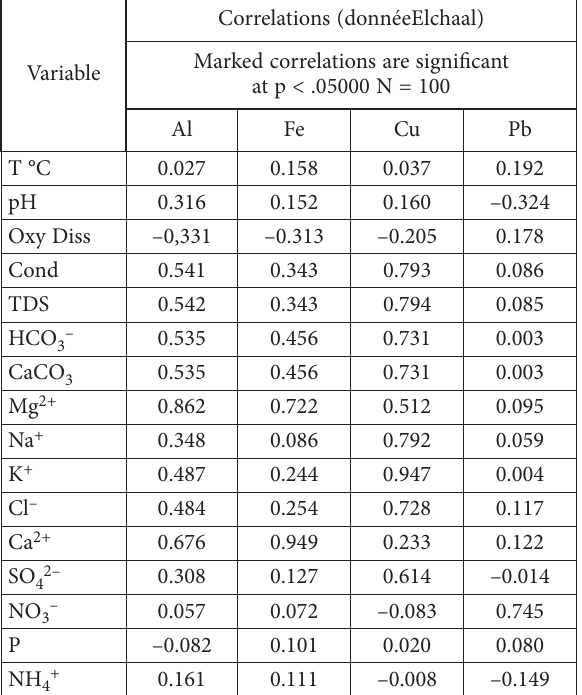
Table 2. Matrix of correlation for 16 variables independent and four heavy metals